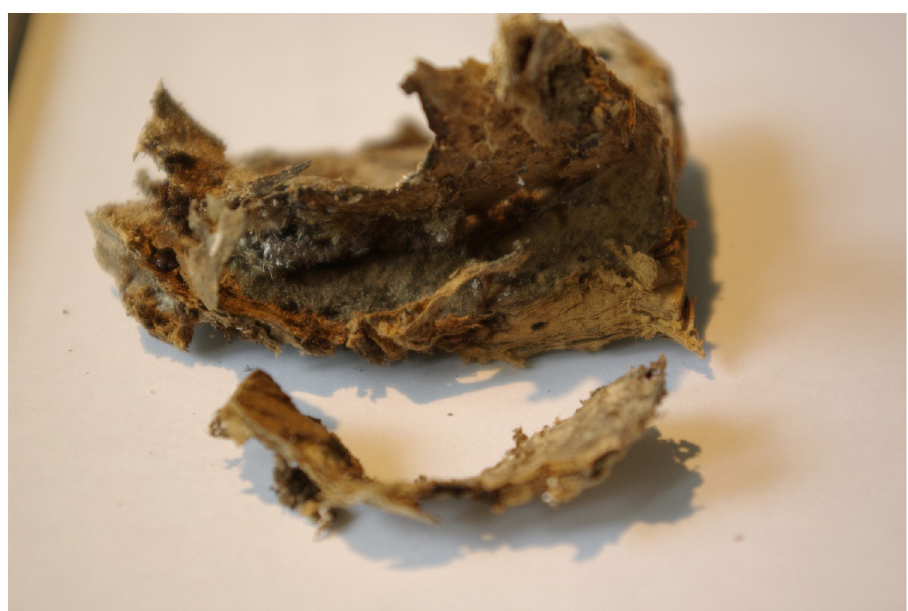
Fig 12. Macro-preparation of the autoptically removed retroperitoneal cyst. The cyst has been incidentally opened during removal from the body.